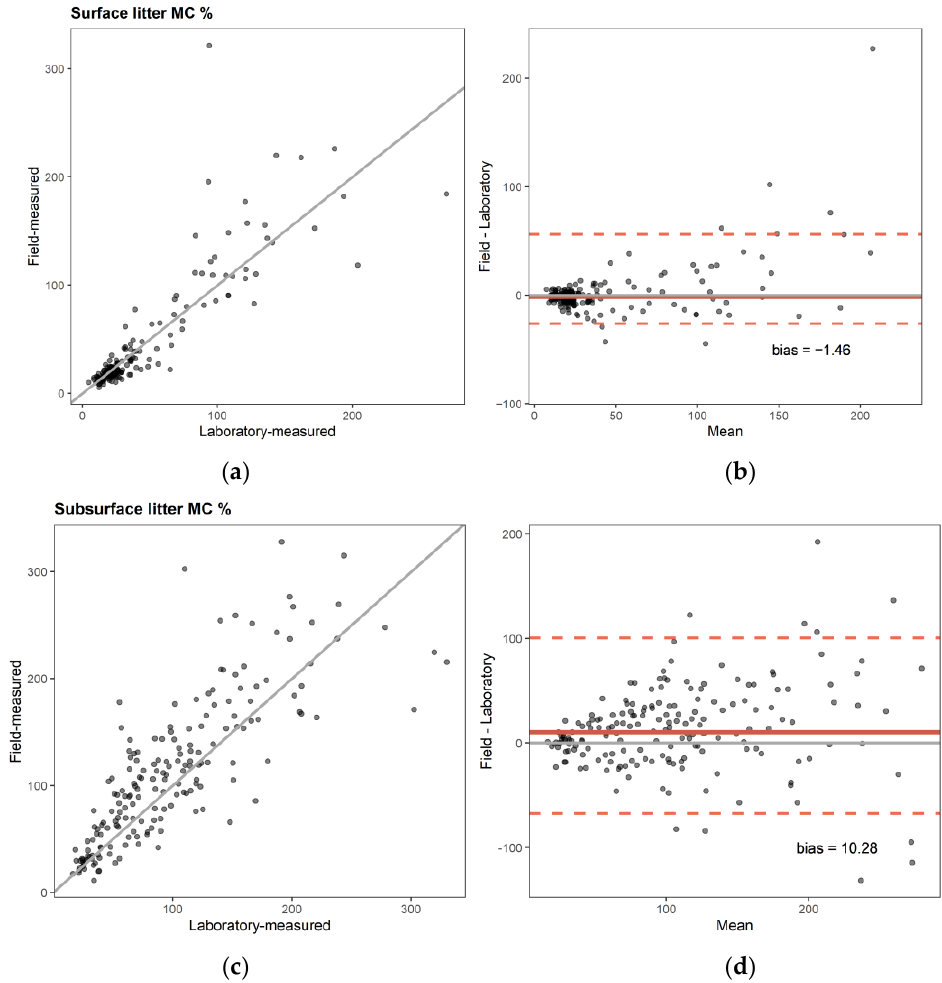
Figure 3. Comparing moisture content measured in the field and the laboratory: ( a ) laboratory-measured vs. field-measured surface litter moisture content (MC); ( b ) Bland–Altman plot for surface litter moisture content; ( c ) laboratory-measured vs. field-measured subsurface litter moisture content; ( d ) Bland–Altman plot for subsurface litter moisture content. The solid red line represents the median bias between the laboratory and field results. The dashed red line represents the agreement interval, calculated as the 2.5th and 97.5th percentiles. The solid grey line represents the line of agreement (difference = 0).